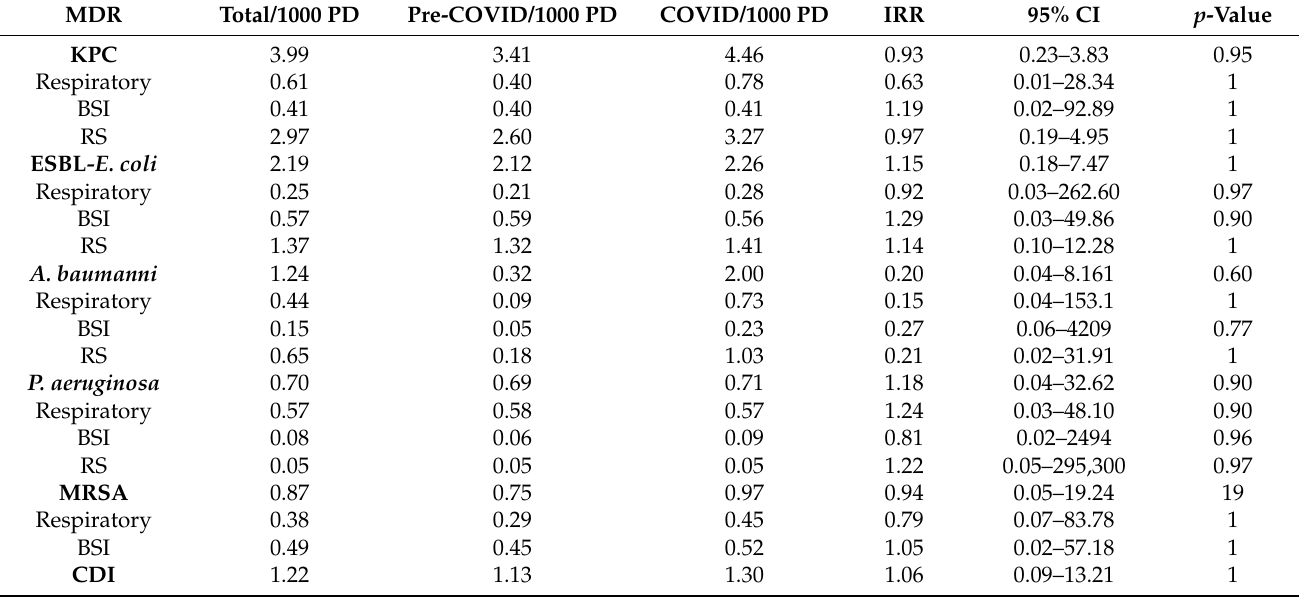
Table 2. Incidence rate ratios for adjusted isolates per 1000